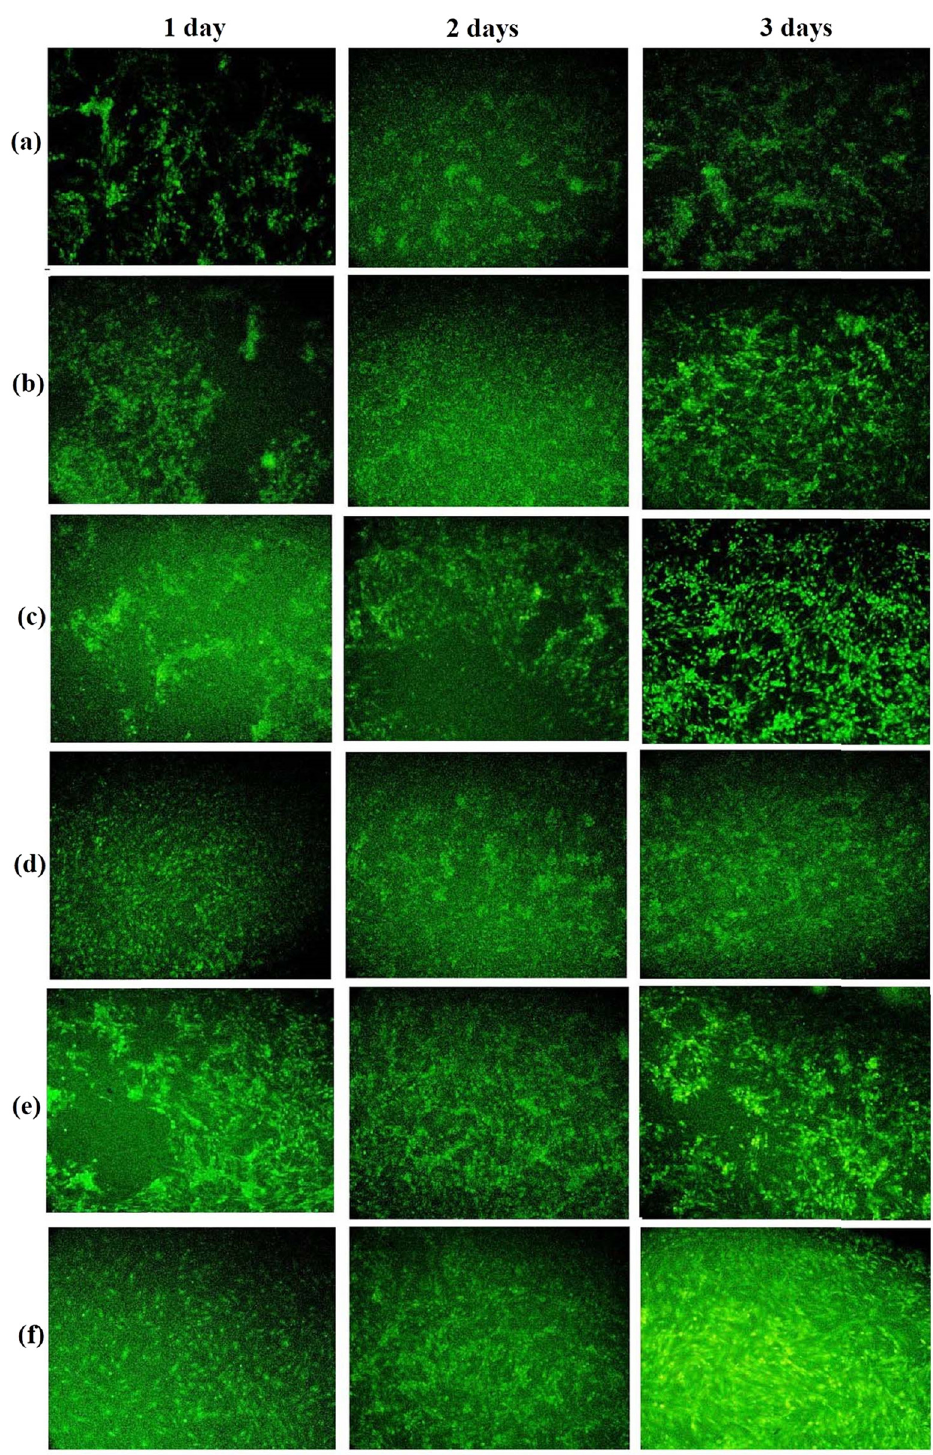
Figure 8: Fluorescence staining micrographs on sample surface: ( a ) CS/n - HA ( 6:2 ) , ( b ) SF/CS/n - HA ( 1:6:2 ) , ( c ) SF/CS/n - HA ( 2:6:2 ) , ( d ) SF/CS/n - HA ( 6:6:2 ) , ( e ) dissolved SF/CS/n - HA ( 1:6:2 ) , and ( f ) un - degummed SF/CS/n - HA ( 1:6:2 ) . The magni fi cation was 40